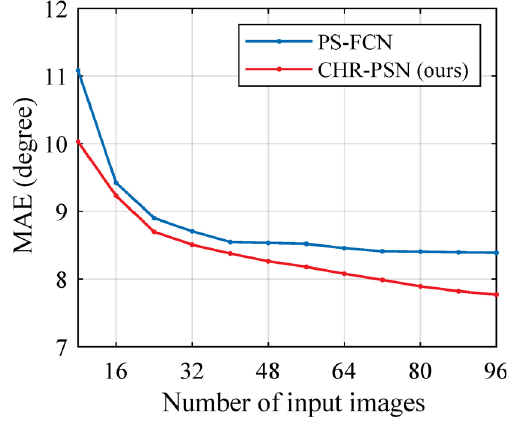
Fig. 5 MAE for different numbers of input